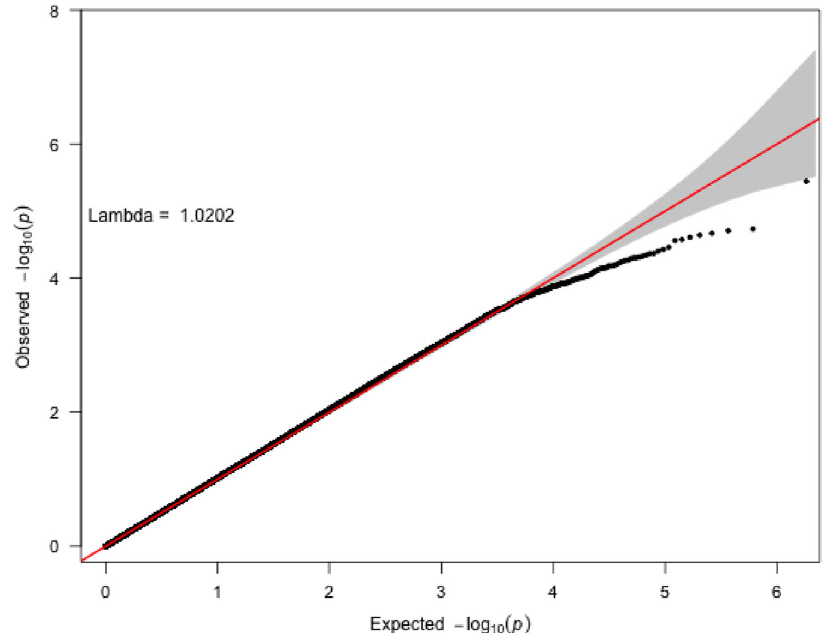
Fig. 3 Quantile – Quantile plot of p -values from the GWAS of HER2 status. Analyses from 8703 patients, 3230 of whom are HER2-positive, are represented. 914144 variants were included in these analyses. The gray area highlights the zone of potentially associated variants